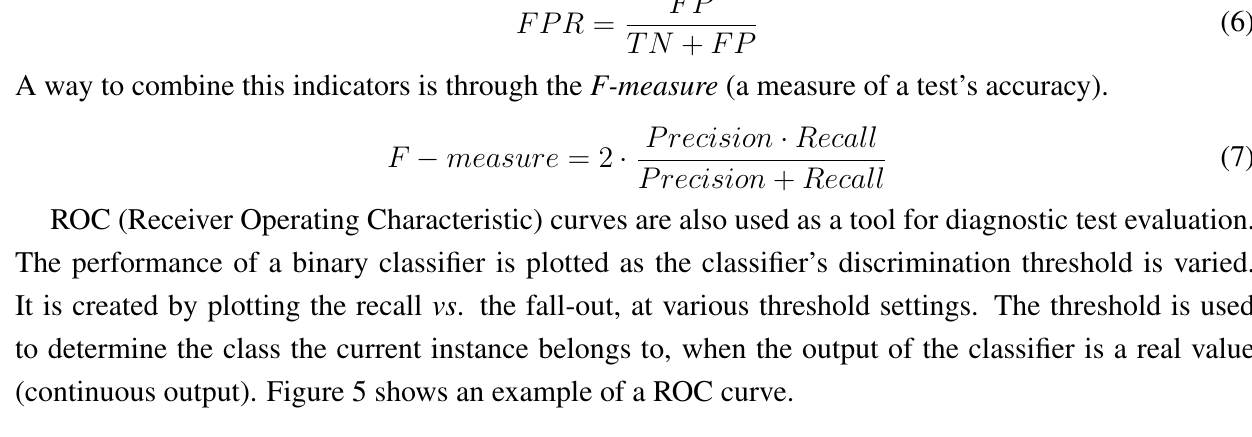
Figure 5. ROC curve